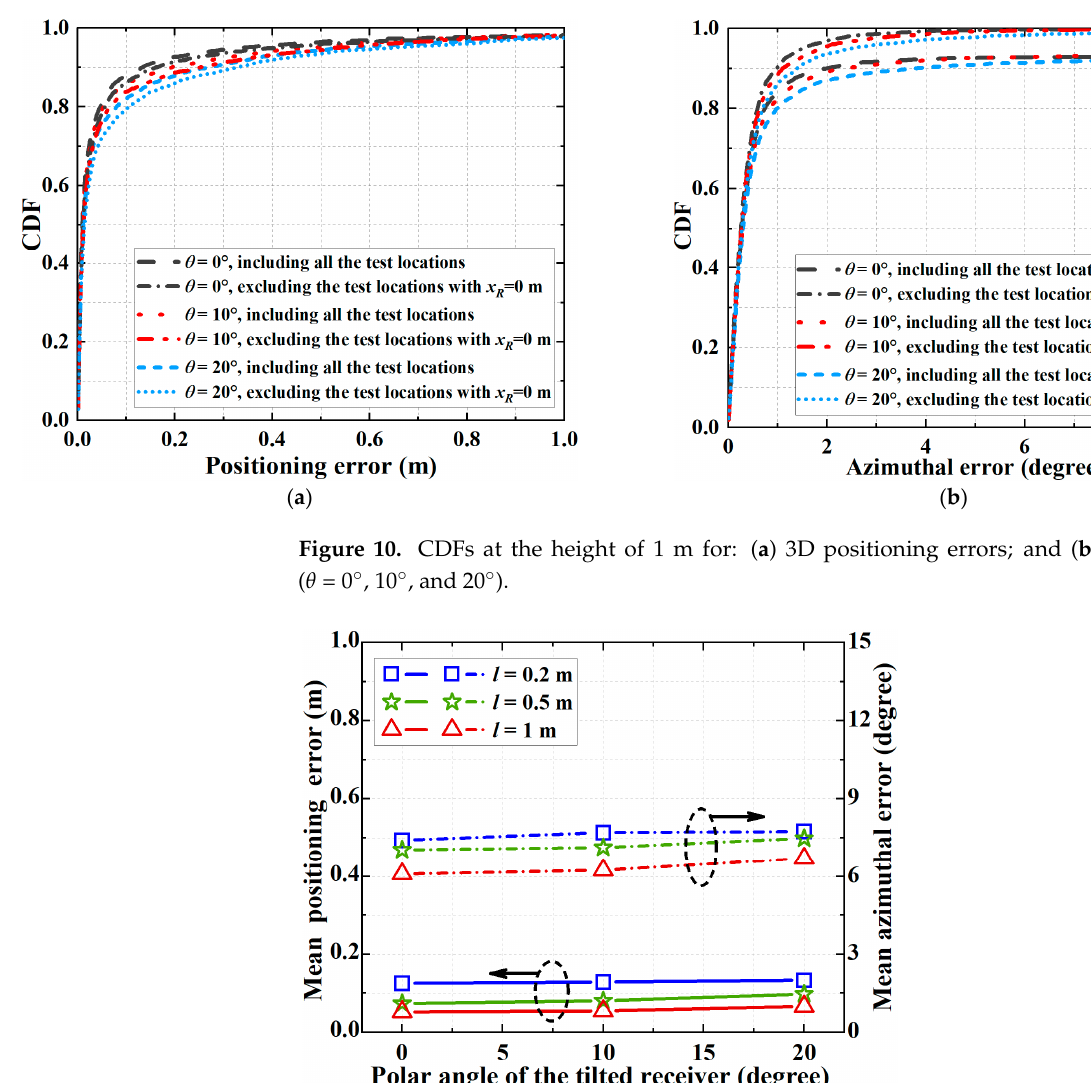
Figure 11. Mean positioning errors and azimuthal errors at the height of 1 m. ( θ = 0°, 10°, and 20°).